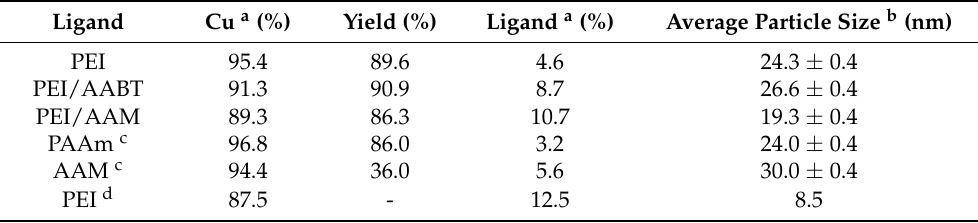
Table 1. Cu NPs synthesis